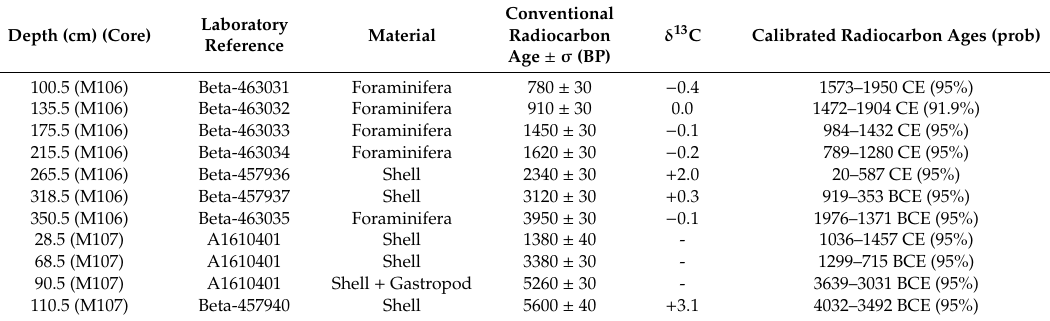
Table 2. Radiocarbon ages obtained from the 2 cores M106 and M107. Calibrated radiocarbon ages are minimum and maximum values of the calibrated ages with “rbacon” [77] (see text in chapter 2.3. for more details). BP = before present (i.e., before 1950 CE); CE = common era; BCE = before common era; prob =